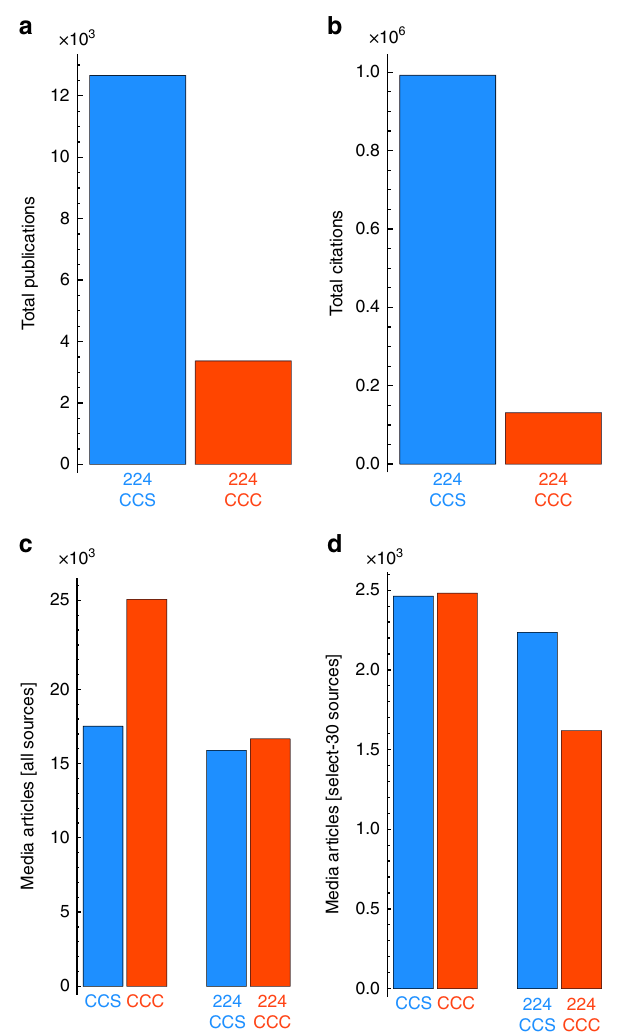
Fig. 3 Discrepancy in scienti fi c authority and media visibility — group level. a Total number of publications by the climate change contrarian (CCC; red) and climate change scientist (CCS; blue) groups. 224CCC indicates the subset of 224 CCCs comprised of just the individuals with at least one Web of Science publication; 224CCS indicates the 224 most-cited CCSs. b Total number of citations from the publications in a . Total number of